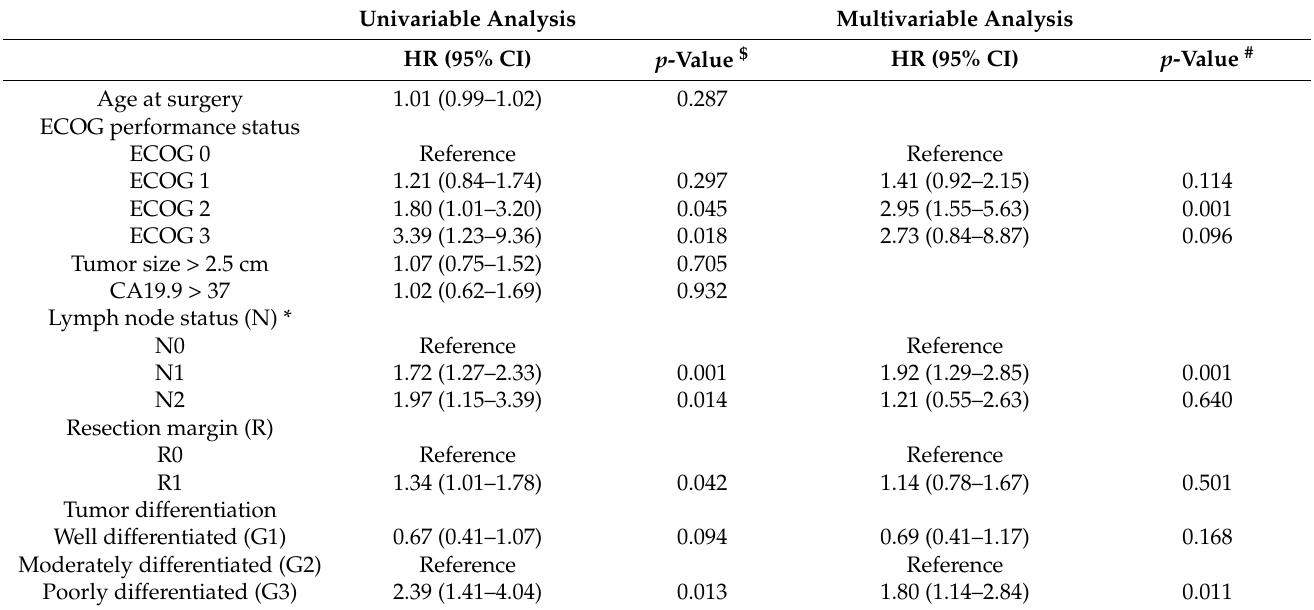
Table 2. Uni- and multivariable Cox regression analysis for overall survival.